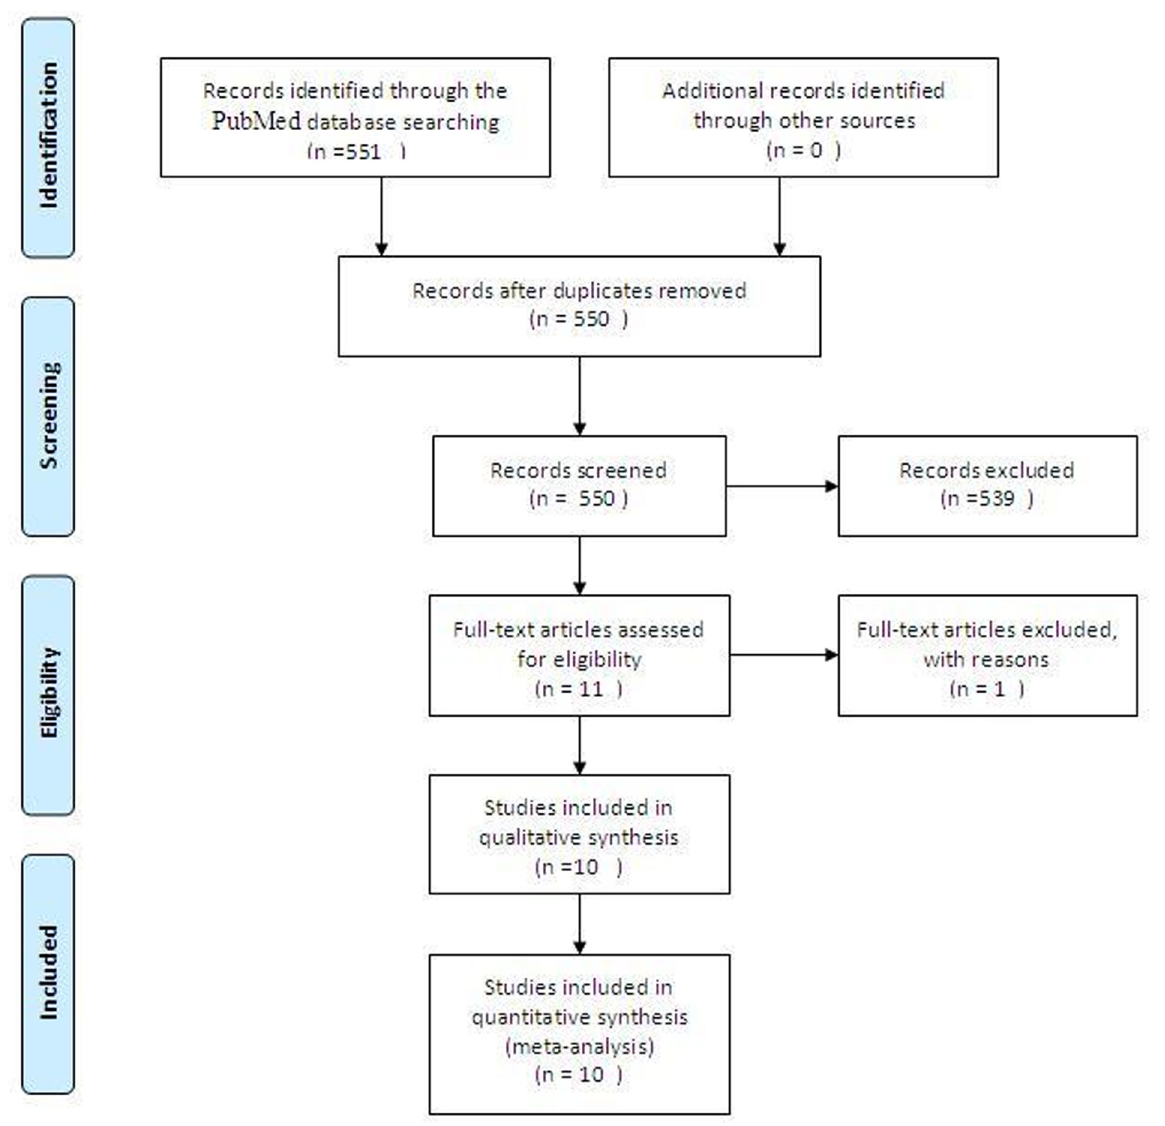
Fig 1. Flow Diagram for the Selection of